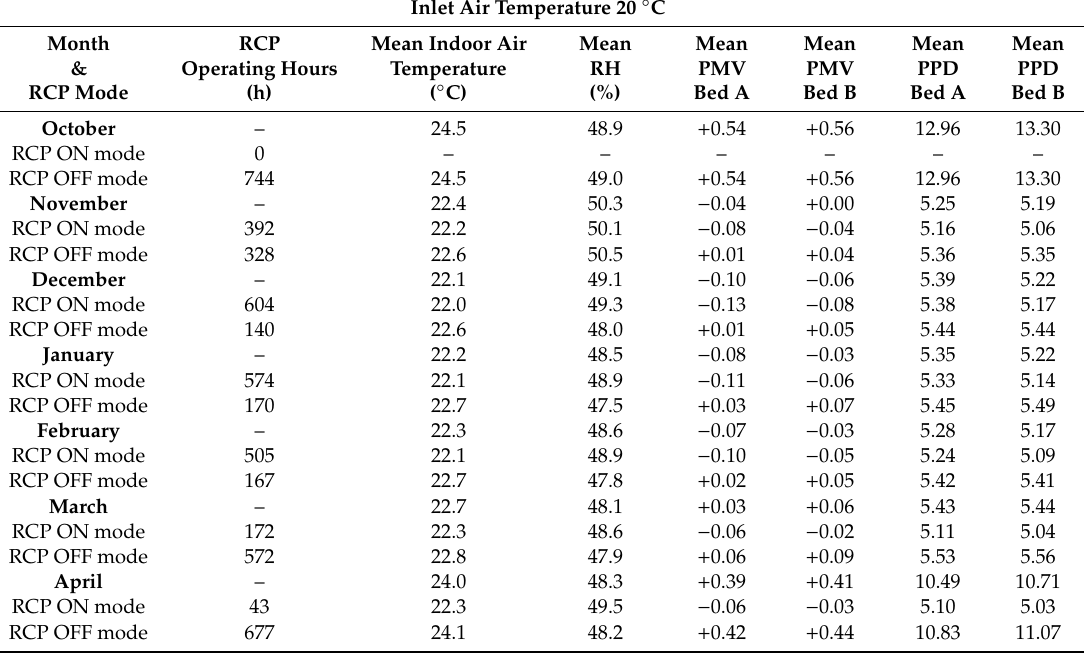
Table 5. Monthly RCP operating hours, mean indoor air temperature, RH, PMV and PPD with inlet air temperature of 20 ◦